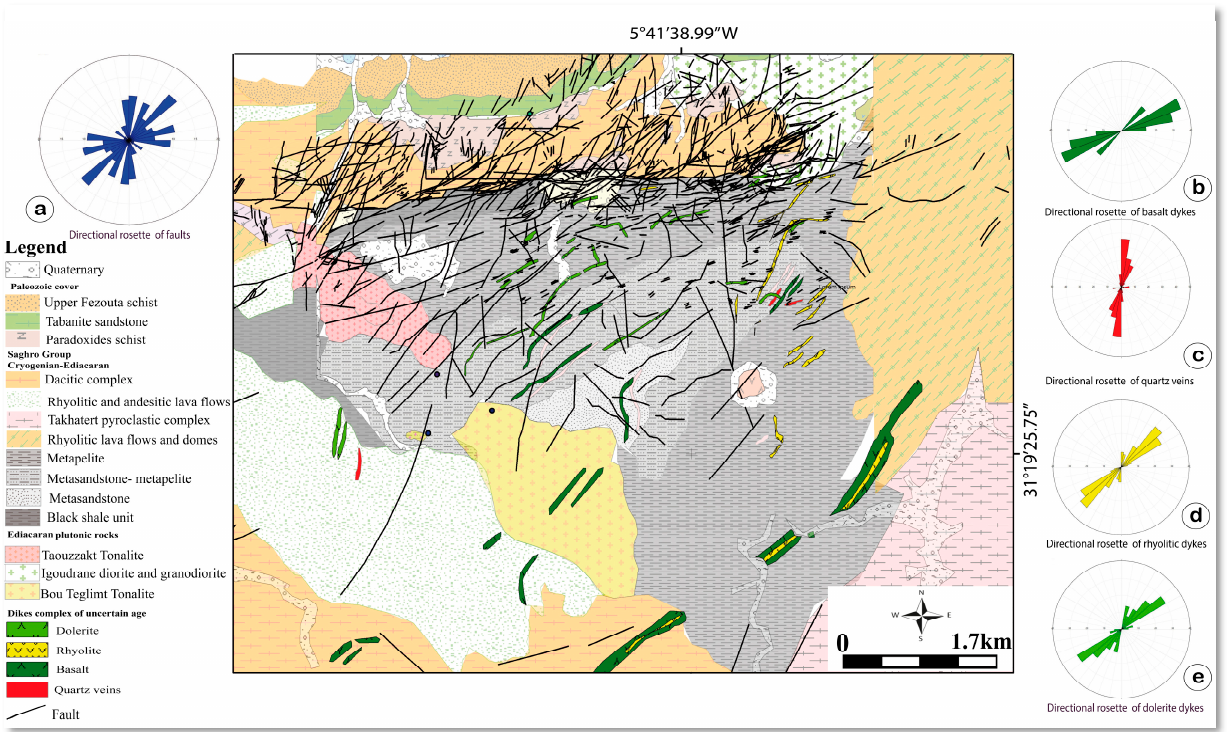
Figure 4. Structural map showing the major fault systems in the Imiter area; ( a – e ) respectively show directional rosettes of faults, basaltic dykes, quartz veins, rhyolitic dykes, and dolerite dykes.